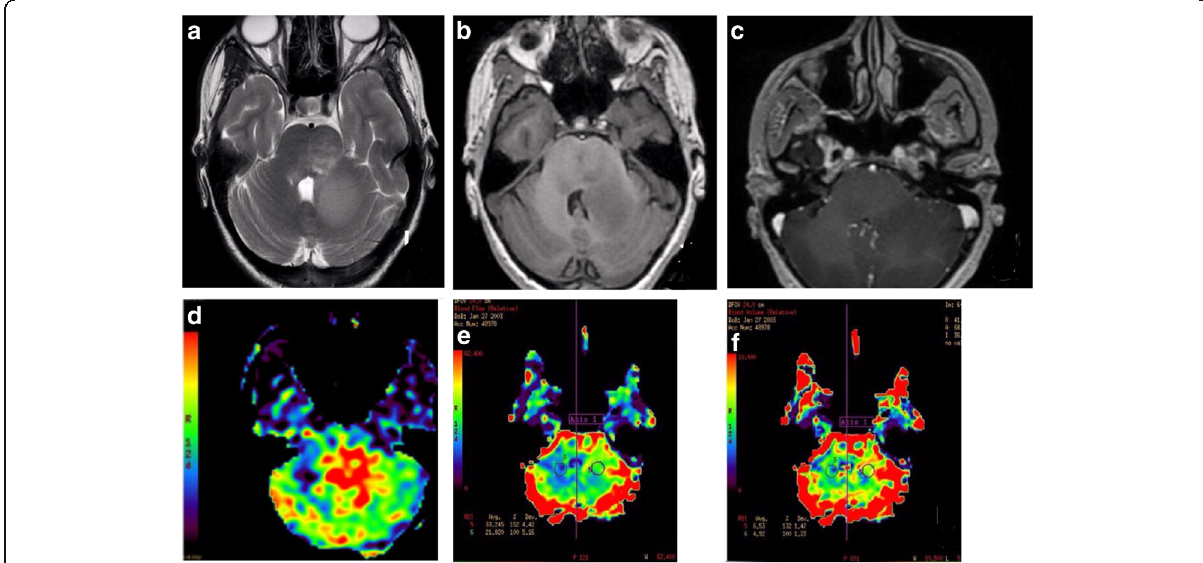
Fig. 2 MR perfusion in a case with the left middle cerebellar peduncle (MCP) low-grade glioma. a Axial T2WI showing left MCP hyperintense lesion. b , c Pre- and post contrast T1WI showing hypointense signal with no post contrast enhancement. d ASL-CBF showing hyperperfusion of the lesion with ASL-rCBF value of 4.76. e , f DSC-CBF and CBV showing isoperfusion with a DSC-rCBF value of 0.9 and DSC-rCBV value of 1.1. Pathologically proven low-grade glioma with ASL not matching with DSC, hyper on ASL and iso on DSC. ASL arterial spin labeling, CBF cerebral blood flow, DSC dynamic susceptibility contrast, CBV cerebral blood volume, r relative, WI weighted